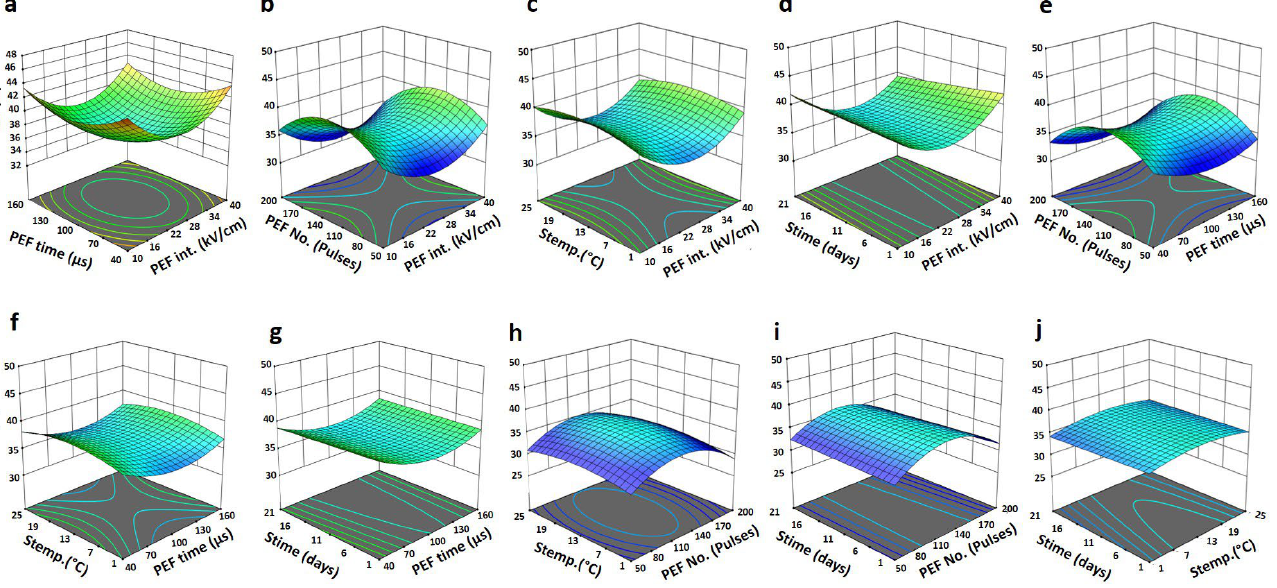
Figure 4. Response surface plots of total color change (ΔE) of Barhi dates as a function of PEF time and PEF intensity ( a ), PEF number of pluses and PEF intensity ( b ), storage temperature and PEF intensity ( c ), storage time and PEF intensity ( d ), PEF number of pulses and PEF time ( e ), storage temperature and PEF time ( f ), storage time and PEF time ( g ), storage temperature and PEF number of pulses ( h ), storage time and PEF number of pulses ( i ), and storage time and storage temperature ( j ).